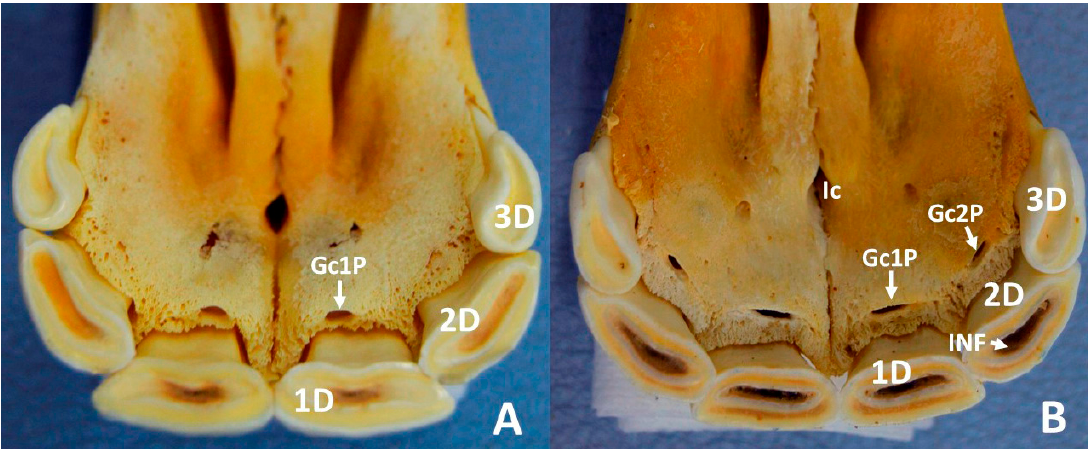
Figure 2. Ventral view of maxillary dental arcade, incisive part, of skull of group 1a ( A ) and of group 1d ( B ). 1D , right 1st deciduous incisor—501; 2D , right 2nd deciduous incisor—502; 3D , right 3rd deciduous incisor—503; Gc1P , gubernacular canal of right 1st permanent incisor—101; Gc2P , gubernacular canal of right 2nd permanent incisor—102; Ic , incisive canal; INF , infundibulum of the right 2nd deciduous incisor—502.